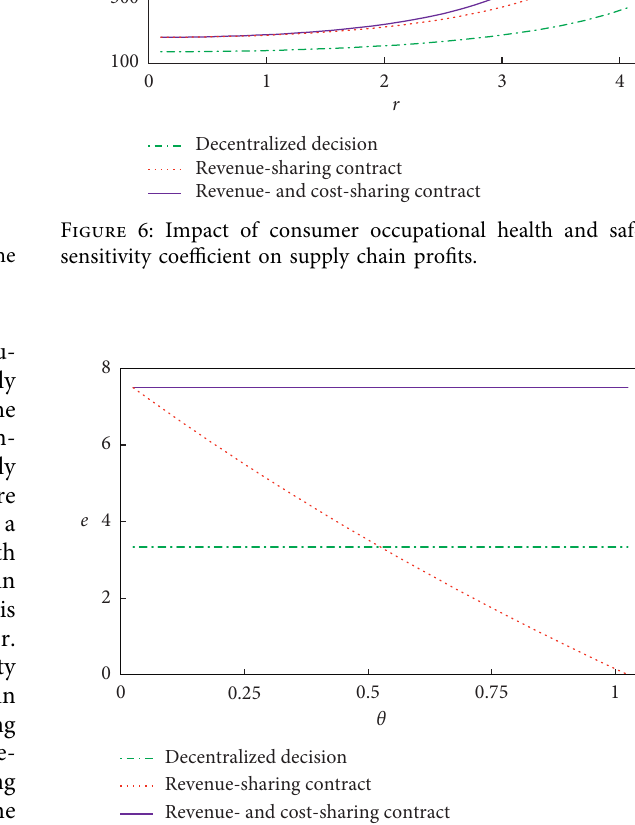
Figure 7: Impact of revenue-sharing coefficient on the work safety